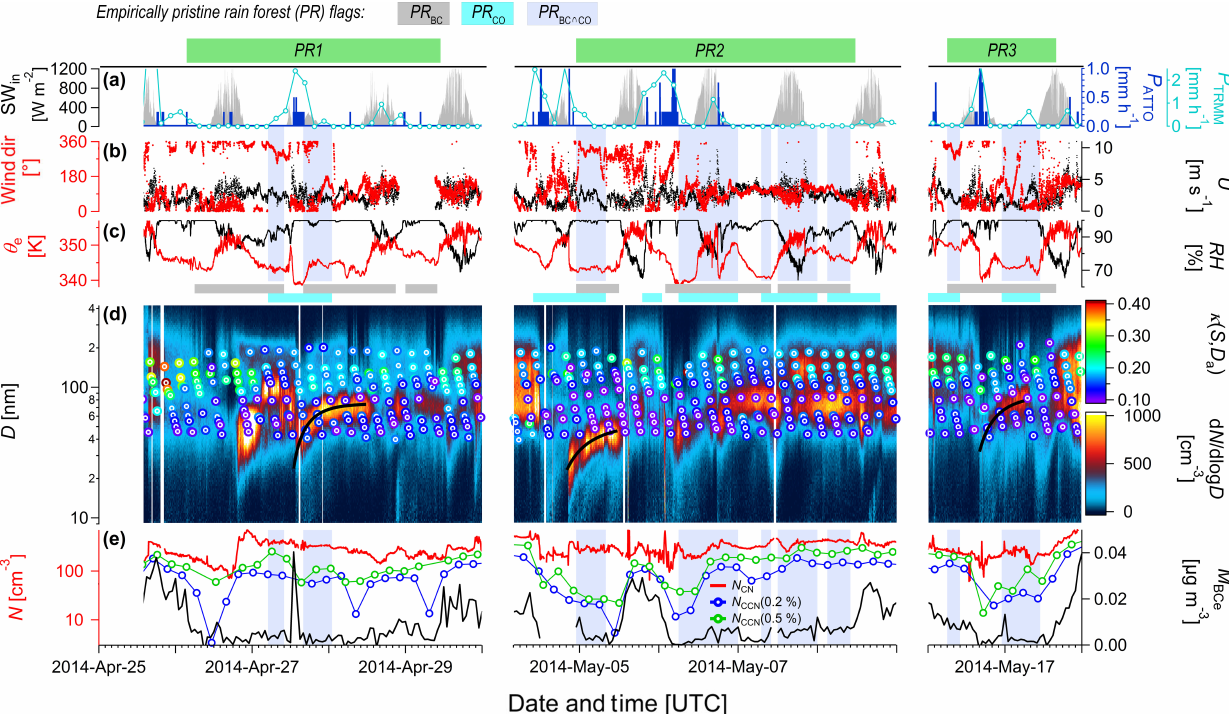
Figure 5. Selected meteorological, aerosol, and CCN time series from ATTO measurements for the empirically pristine rain forest (PR) case study periods PR1, PR2, and PR3 (see Fig. 3). (a) Incoming shortwave radiation, SW in ; precipitation rates from TRMM satellite mission, P TRMM ; and in situ measurements at ATTO, P ATTO . (b) Wind direction and wind speed, U , at ATTO. (c) Equivalent potential temperature, θ e , and relative humidity, RH, at ATTO. (d) Overlay of two data layers showing aerosol number size distribution contour plot, d N /dlog D , as well as color-coded markers, representing time series of κ(S,D a ) size distributions. (e) CCN concentrations, N CCN (S ), for two selected S levels; total aerosol number concentration, N CN , 10 ; and BC e mass concentration, M BC . Vertical shadings represent PR BC ∩ CO periods e according to the definition in Sect.